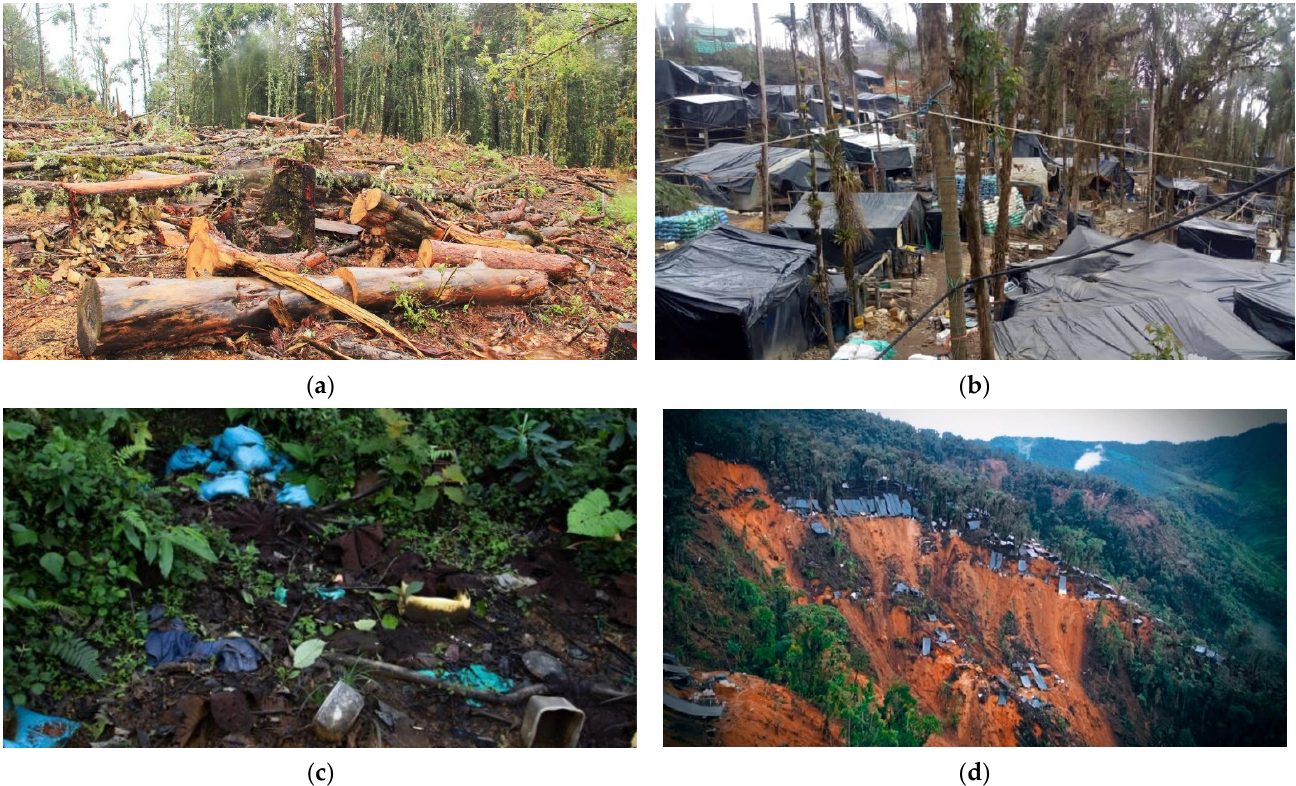
Figure 2. Environmental impacts; ( a ) vegetation clearing; ( b ) camp construction; ( c ) trash contami- nation; ( d ) erosion, landslides, and landslides.